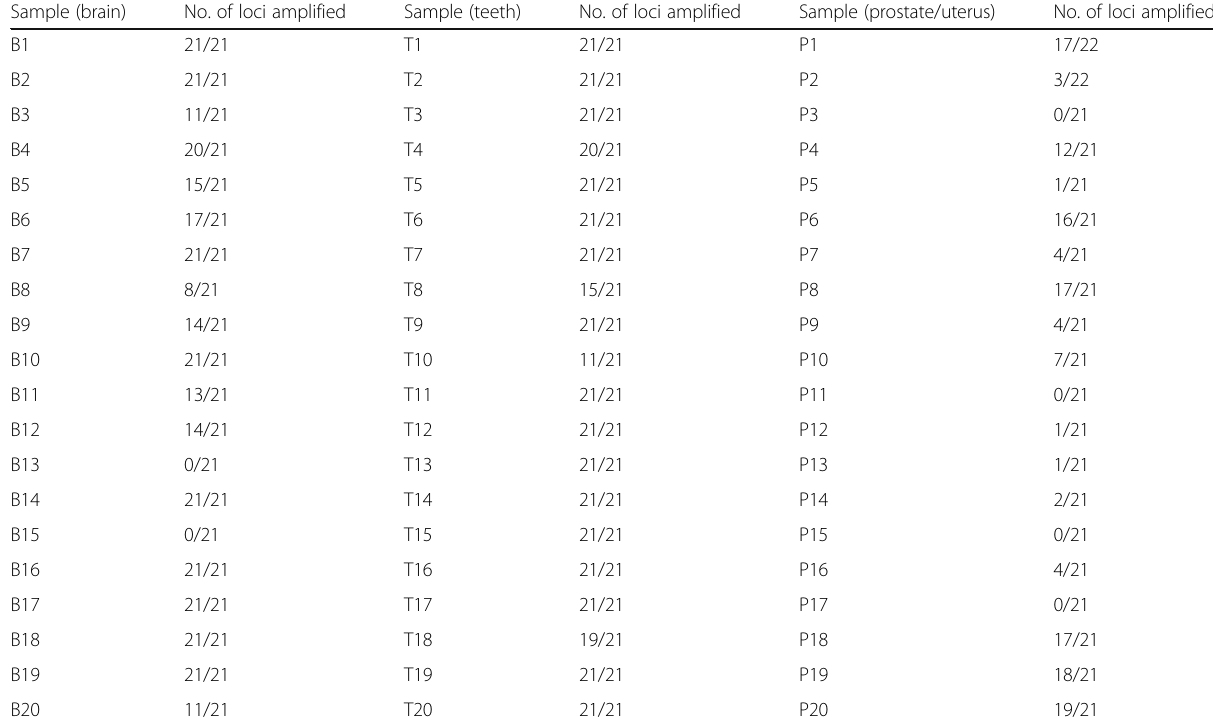
Table 1 Amplifiable STR loci for all the three samples Sample (brain)